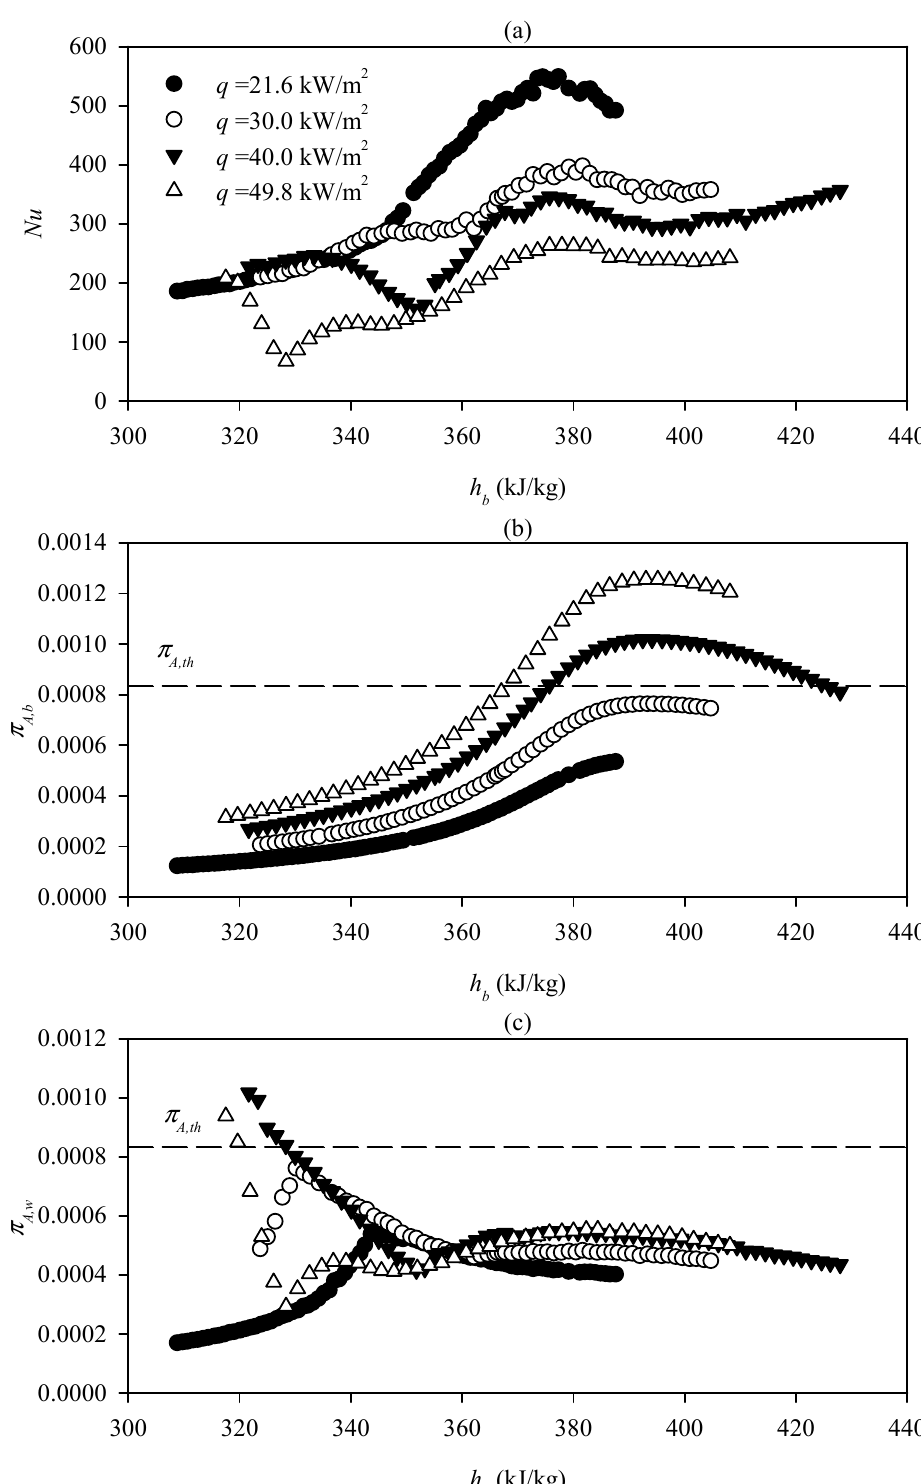
Figure 7. ( a ) Nusselt number, ( b ) π A at both bulk and ( c ) wall condition vs. enthalpy for R-134a at mass flux of 600 kg / m 2 · s subject to heat fluxes [16].